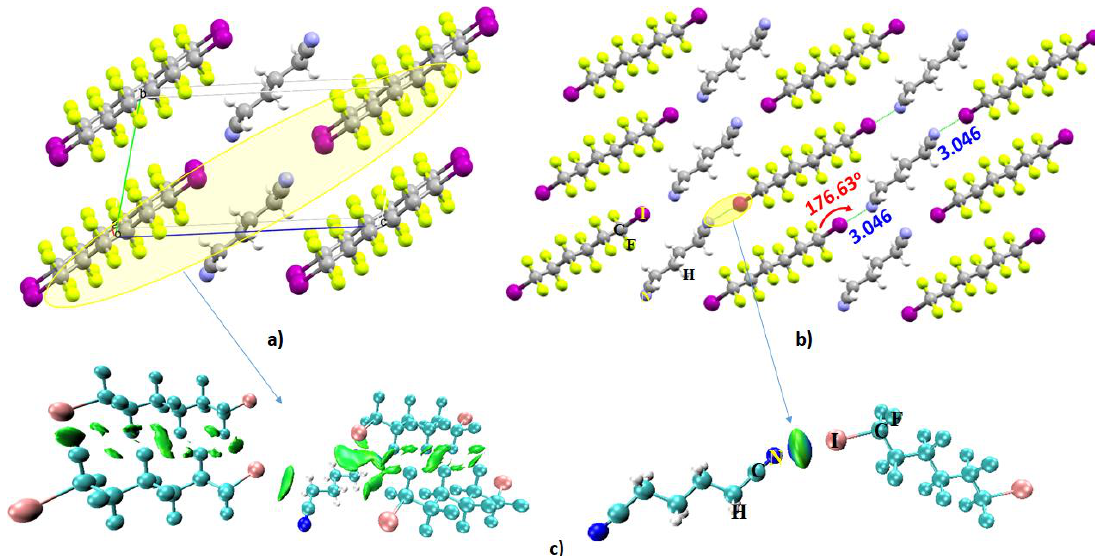
Figure 22. ( a ) The unit cell and ( b ) 2 × 2 supercell representations of the crystal structure of 1,4-dicyanobutane and ICF 2 (CF 2 ) 4 CF 2 I (CSD ref: EBIJAB). ( c ) The results of the IGM isosurface plot (isovalue = 0.004 a.u.) are illustrated for some specific regions. Selected bond distances and bond angles are given in Å and degree, respectively.